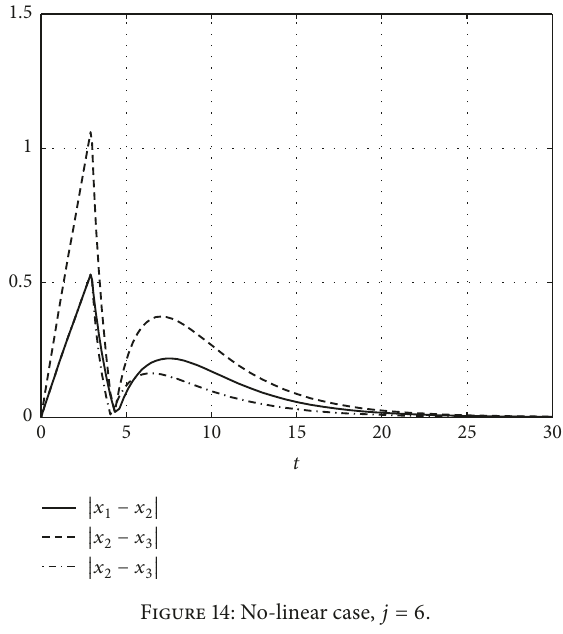
Figure 14: No-linear case, 𝑗 = 6